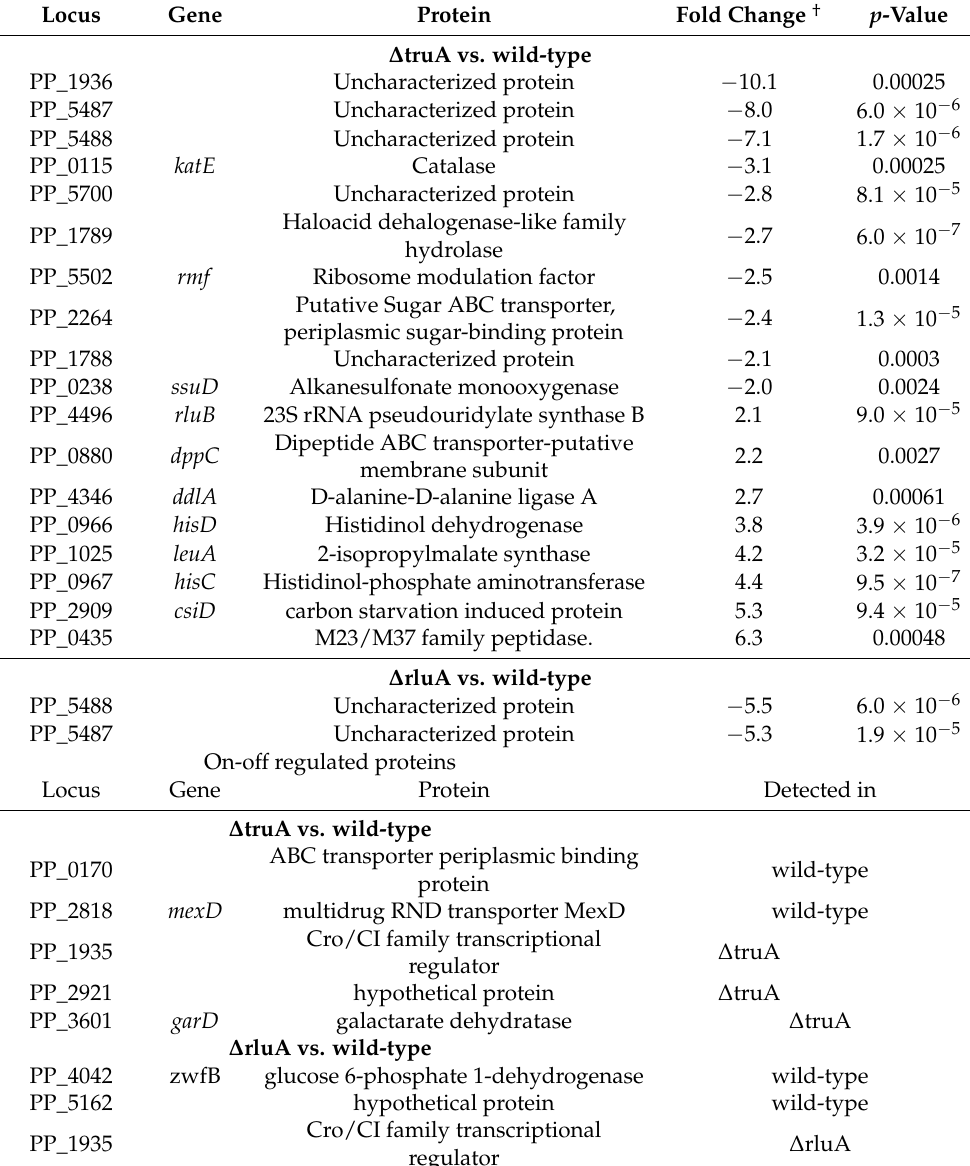
Table 1. Protein expression levels altered in Pseudomonas putida ∆ truA or ∆ rluA compared to wild-type